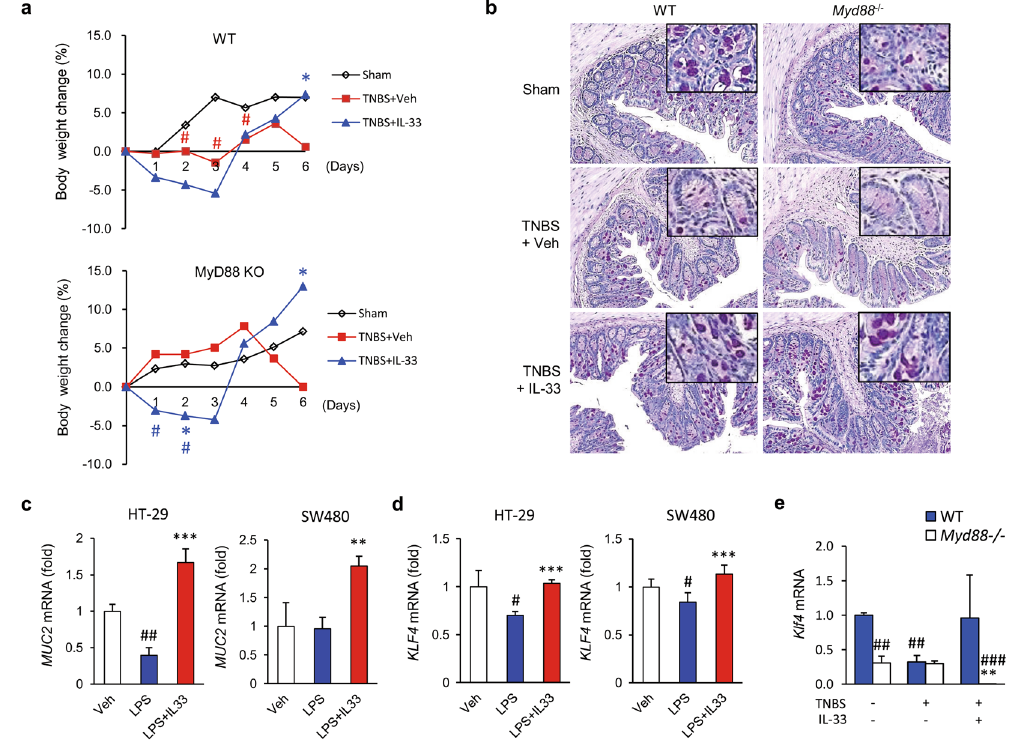
Figure 3. MyD88 independent effects of IL-33 on goblet cell restoration in inflammation. ( a , b , e ) Effects of IL-33 on colitis and goblet cells in the colon of wild-type (WT) and MyD88 deficient ( MyD88 − / − ) mice after low-dose 2,4,6-trinitrobenzenesulfonic acid (TNBS) administration (n = 5 mice/group). To assess the effects of IL-33 on enterocyte early in colitis, 100 µ l TNBS solution (1.8% (w/v)) in 40% ethanol was injected into the colon of each mouse. ( a ) Changes in body weight. The weight of each mouse was followed daily. ( b ) Representative image of periodic acid-Schiff (PAS) staining of the colonic mucosa for goblet cells. Original magnification: x200. ( c , d ) Effects of IL-33 on MUC2 ( c ) and KLF4 ( d ) mRNA expression in human colonic epithelial cells. HT-29 cells were treated with vehicle (Veh) or lipopolysaccharide (LPS, 100 ng/ml), with or without human recombinant IL-33 (hrIL-33), for 4 hours. Total RNA was extracted and analysed by quantitative RT-PCR. Target mRNA expression levels were normalised to that of β -actin . Results are representative of two independent experiments. ( e ) Effects of IL-33 on Klf4 mRNA expression in the mouse colon. Values are expressed as means; error bars represent ± SD. # P < 0.05 vs. Sham control, * P < 0.05 vs. TNBS or LPS, ** P < 0.01 vs. TNBS or LPS, *** P < 0.005 vs. LPS as assessed by ANOVA. Veh, injected with vehicle; IL-33, once injected with mrIL-33 (1 μ g/mouse) or hrIL-33 (20 ng/ml); TNBS, injected with